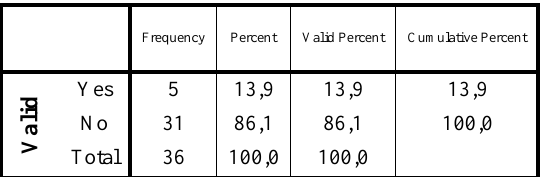
Table 6: Number of Employees in Organizations